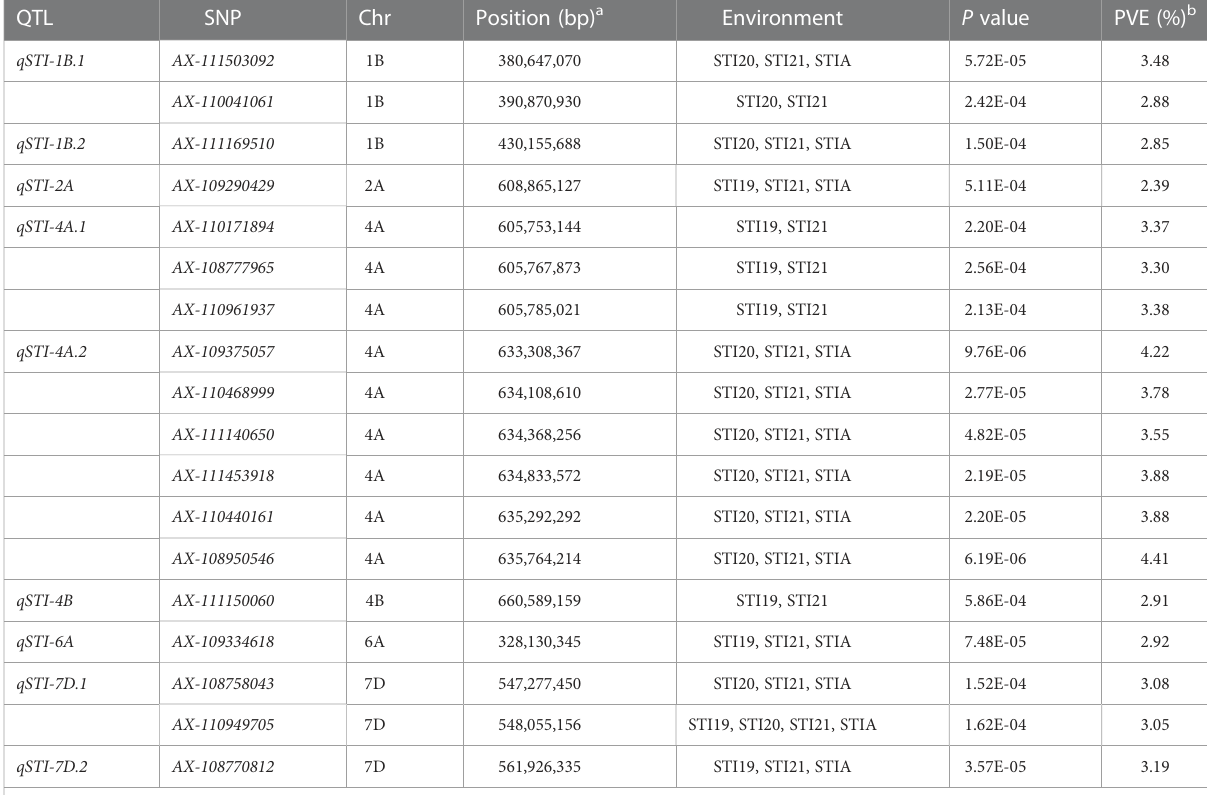
TABLE 4 The QTL and signi fi cant SNPs identi fi ed by GWAS for stress tolerance index (STI).